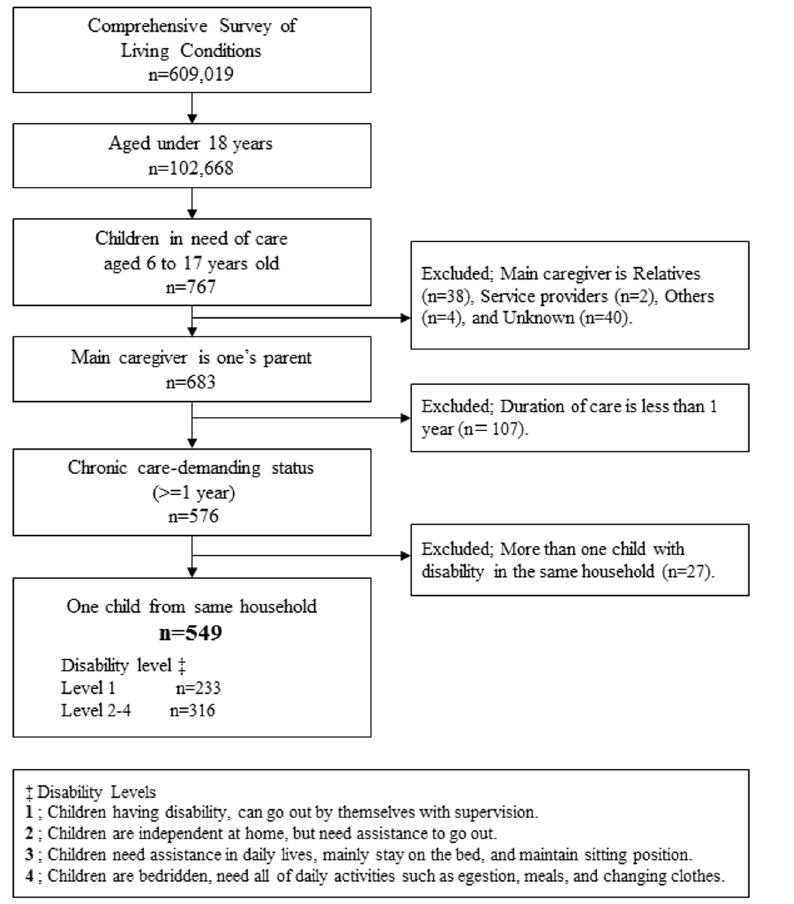
Fig 1. Flow chart of Study